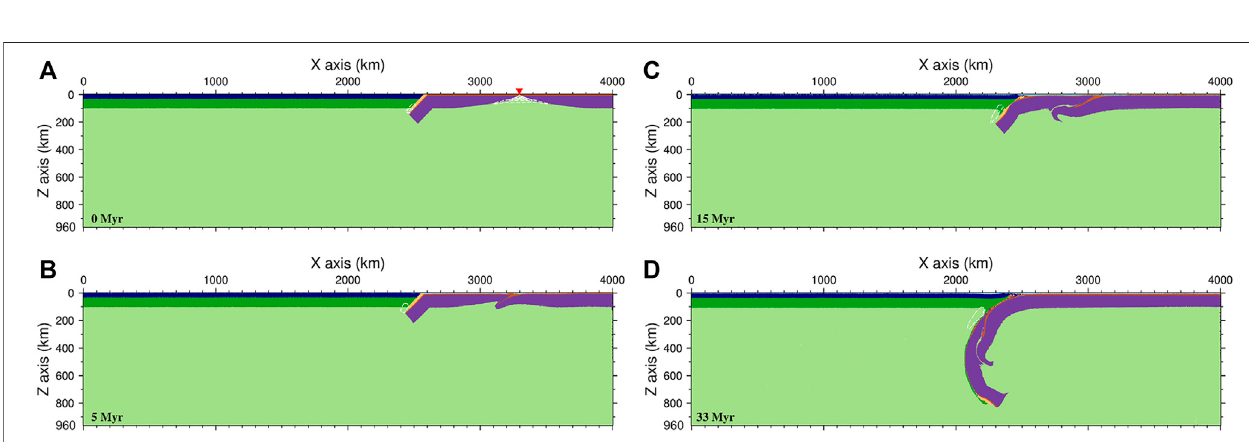
FIGURE 7 | Model evolution of case RS20 ( L (cid:1) 200 km, V x (cid:1) 5 cm/yr, θ (cid:1) 45 ° ) with the ViscT&D viscosity structure. (A – D) Snapshots at 0, 5, 15 and 33 Myrs. The white dashed line represents the extent of melting with an interval of 5%. The red inverted triangle represents the location of the MOR.